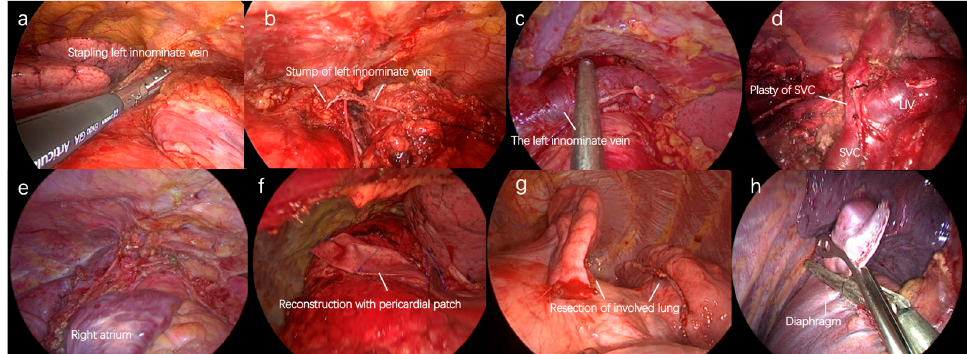
Figure 4. Subxiphoid approach with double sternal elevation for locally advanced thymic tumors. ( a , b ) resection of left innominate vein; ( c ) plasty of left innominate vein; ( d ) plasty of SVC; ( e , f ) resection and reconstruction of pericardium; ( g ) resection of involved lung; ( h ) prophylactic plication of the diaphragm.